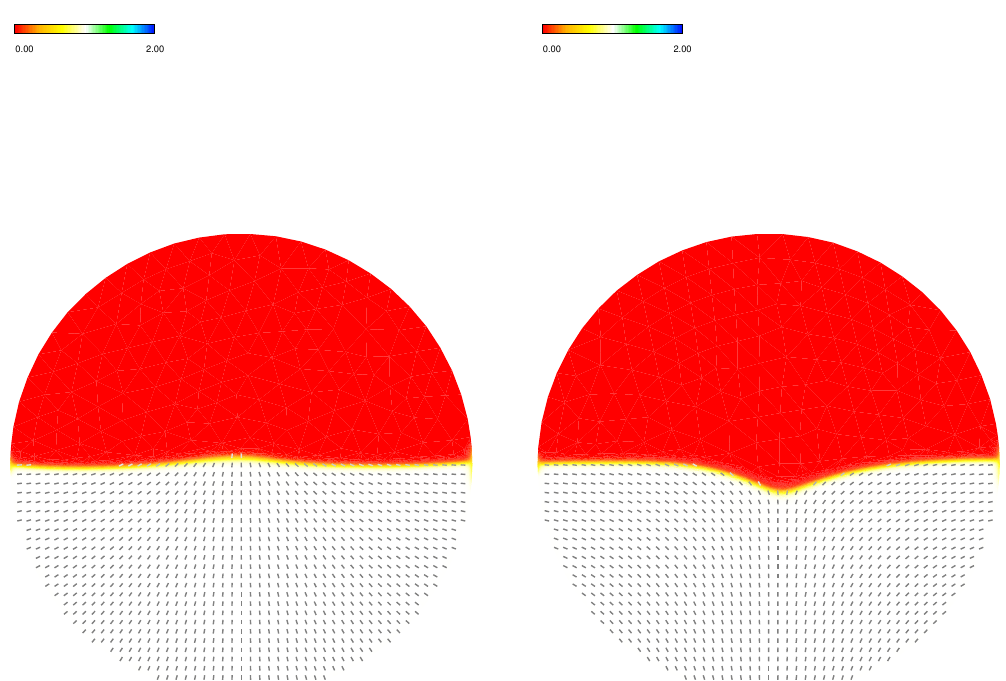
Figure A2. Nematic order parameter (color code) and nematic director (segments) of a nematic–isotropic interfacial configuration with a disclination line of topological charge + 1 ( left ) and − 1 ( right ), for R = 90 ξ .